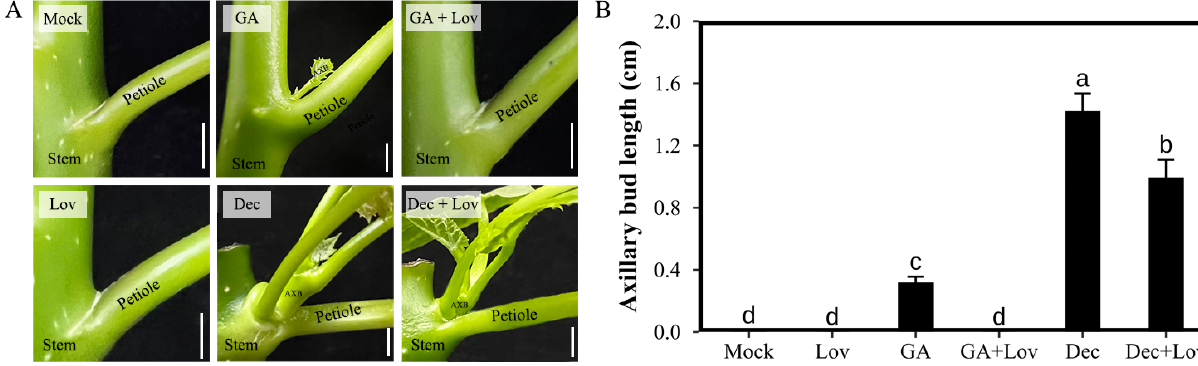
Figure 1. Lovastatin (Lov) inhibited the gibberellin A3 (GA 3 )- and decapitation-promoted outgrowth of axillary buds in 3-week-old J. curcas seedlings. ( A ) Treatment with 200 µM GA 3 and decapitation promoted the outgrowth of axillary buds, while 100 µM Lov inhibited these processes. ( B ) The elongation of axillary buds under different treatments. AXB, axillary bud. Scale bars = 1 cm. All data and photos were taken at 2 weeks after treatment. Different letters indicate significant differences ( p < 0.01, n = 10, one-way ANOVA, Tukey ’ s test).